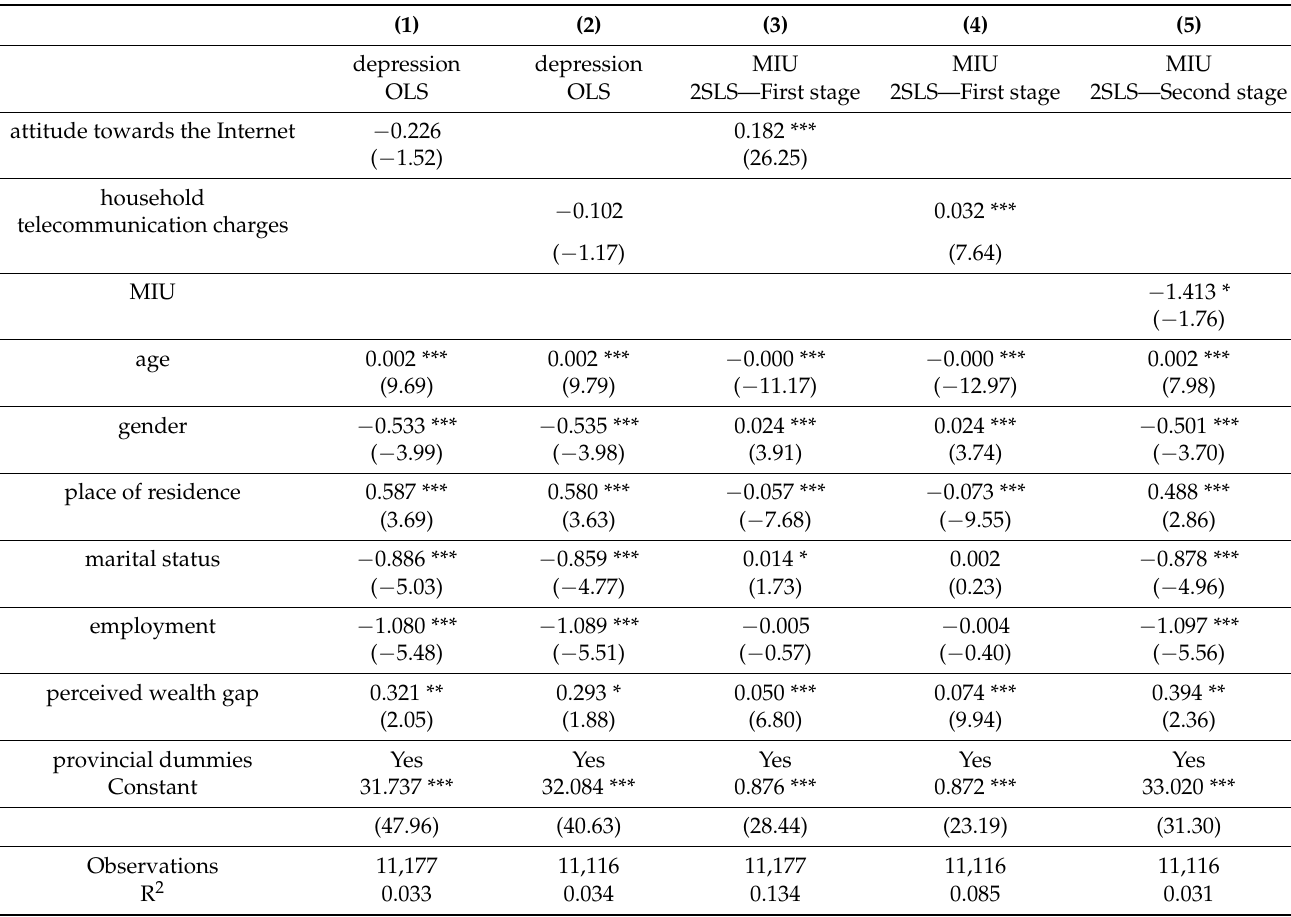
Table 11. Instrumental variable regression results (16–40